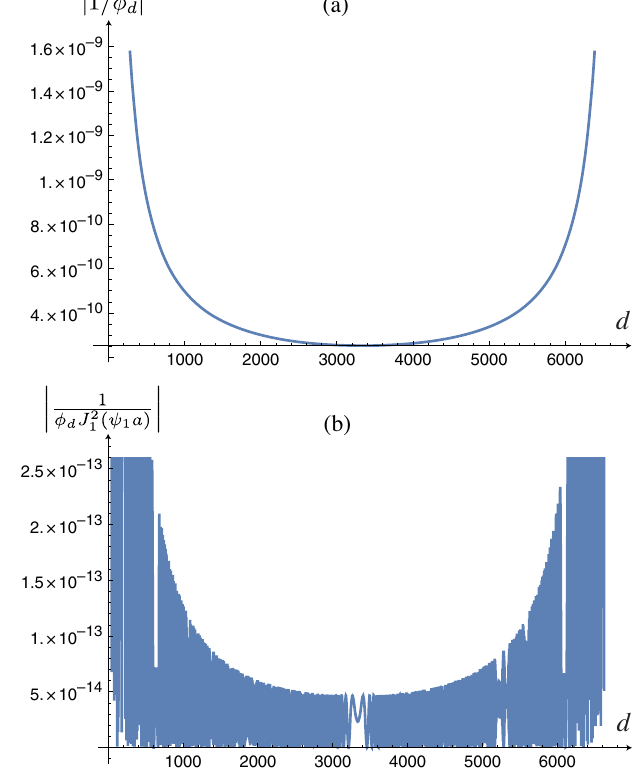
FIG. 14. (a) A plot of the convex modulation function, j ϕ − 1 d j , responsible for the clustering effect, for the overmoded iris-line example with a ¼ 0 . 055 m, b ¼ 0 . 33 m, ε 1 ¼ 0 . 0001 and n 0 of 6666. (b) An example of the effect of the modulation on the oscillatory term 1 =J 2 1 ð ψ 1 a Þ , plotted using the formula (B30) for the same parameters. The edges of the band (where d tends to 0 or 6666), correspond to the dominant harmonic and its image; clustering is manifested in how the envelope of all harmonics decreases as we move away from band